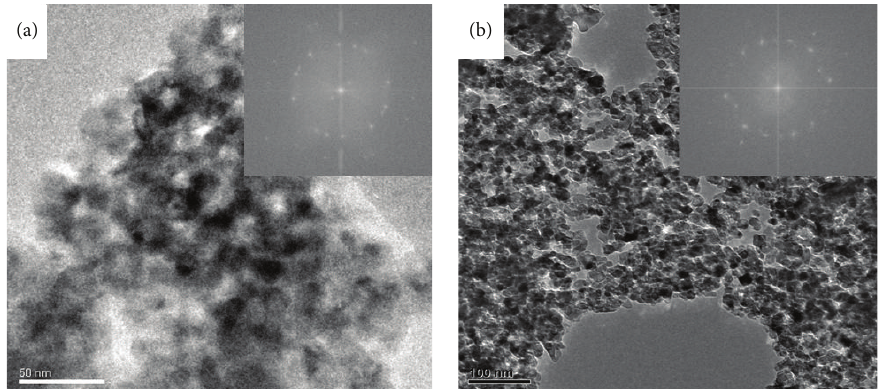
Figure 8: TEM images of the (a) TiO 2 and (b) CCA/TiO 2 nanocatalysts.